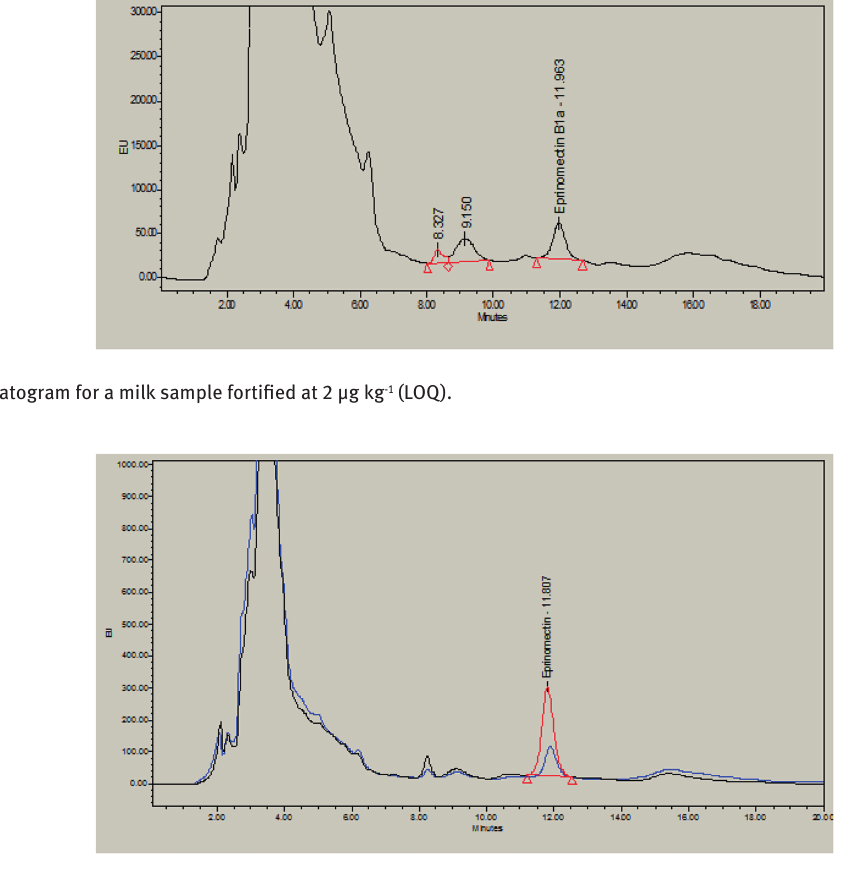
Figure 9: Comparison between chromatograms obtained for milk samples fortified to 10 μg kg -1 and 25 μg kg -1